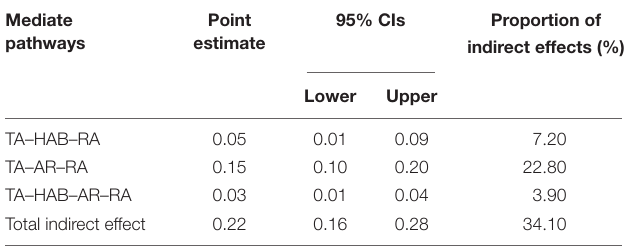
TABLE 2 | Standardized indirect effects and 95% confidence